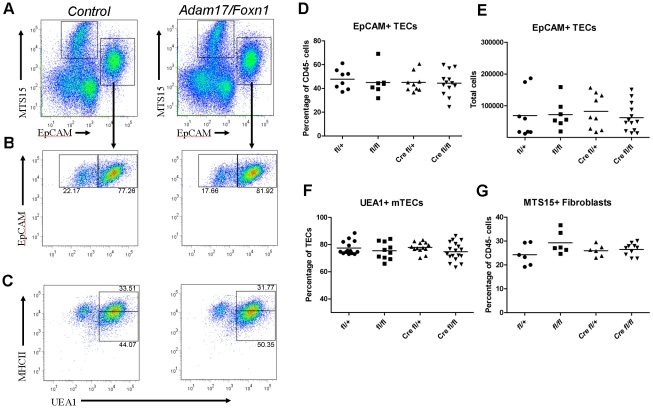
TEC population structure is intact in Adam17/Foxn1 mice.(A) Representative staining of gated CD45-Ter119- thymic stromal cell populations from 8-week old Control and Adam17/Foxn1 mice (B and C) Within the EpCAM+ TEC population, staining for UEA1 alone (B), and MHCII plus UEA1 (C) are shown, with frequencies of UEA1-, UEA1+, UEA1+MHCIIhi, and UEA1+MHCIIint indicated. Data are representative of Control, n = 6 and Adam17/Foxn1, n = 10. (D) TEC frequencies and (E) total numbers determined based on population frequencies and total cell counts as determined by FACS. (F) Frequency of the UEA1+ fraction within the CD45-Ter119-EpCAM+ fraction. (G) Frequencies of MTS15+ fibroblasts. In Parts D through G, the graphs report the mean value and each data point represents an individual mouse. Data between genotypes were not statistically significant, with p>0.05. Control: fl/+ or fl/fl; Adam17/Foxn1: Cre fl/fl.